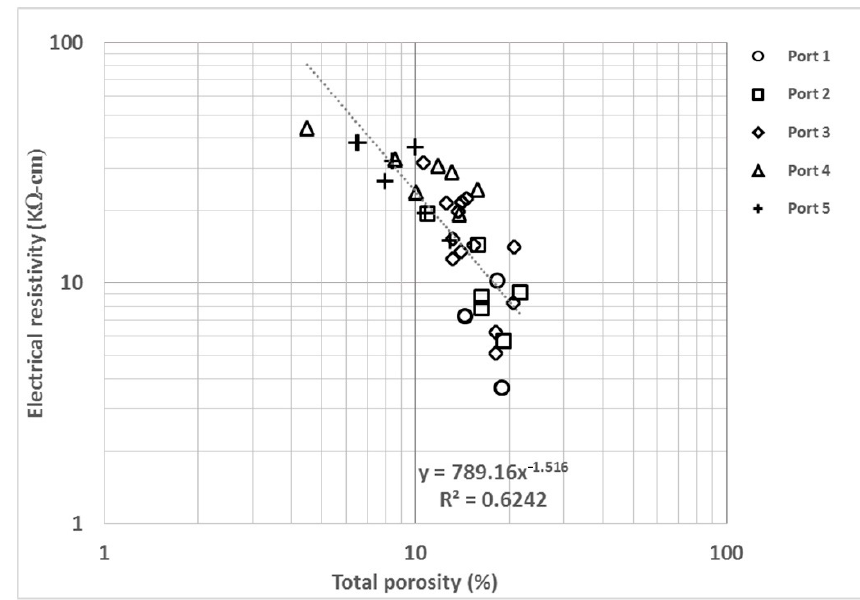
Figure 3. Electrical resistivity (ER) vs. total porosity (TP).